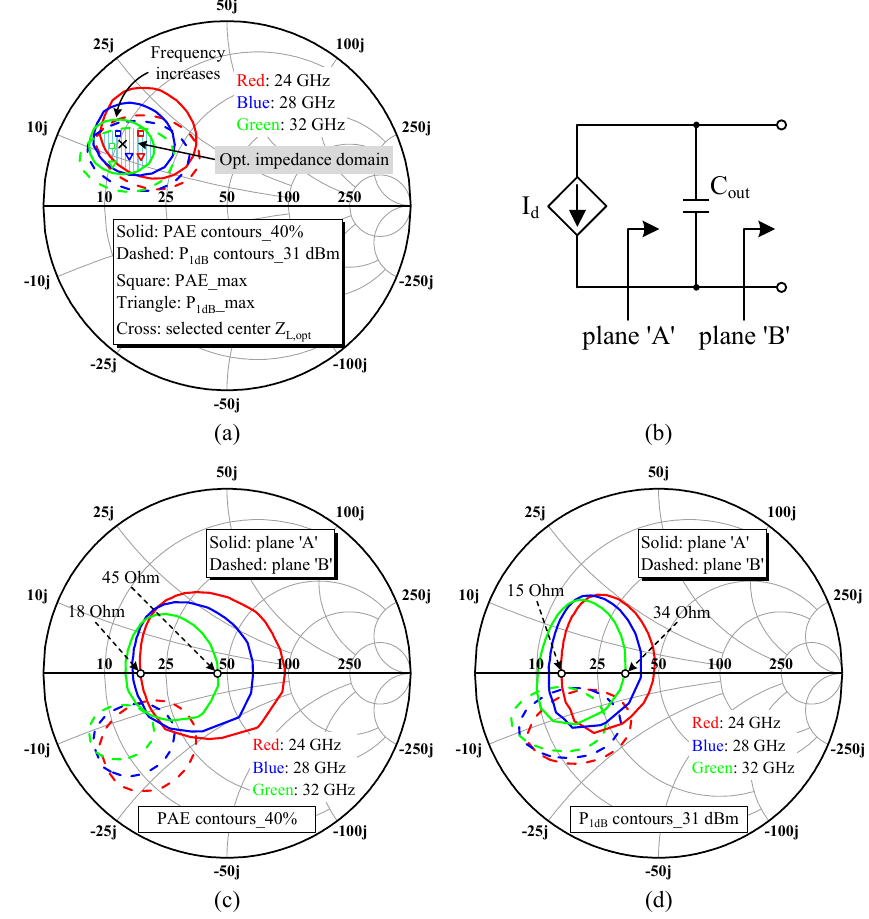
Figure 5. ( a ) Load-pull simulations at 1 dB gain compression. ( b ) Reference planes for the equivalent circuit of the transistor. ( c , d ) Extracted PAE and P 1dB contours at plane ‘A.’